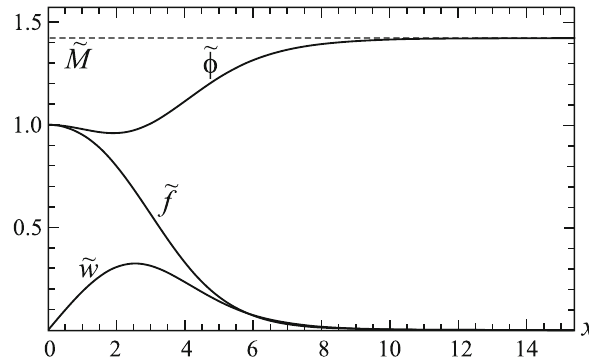
Fig. 5 Thegraphsofthefunctions ˜ w, ˜ φ ,and ˜ f forthefollowingvalues of the system parameters: ˜ λ = 2 , ˜ (cid:6) = 0 . 1 , ˜ φ 0 = 1 , ˜ w 1 = 0 . 2 , ˜ f 0 =